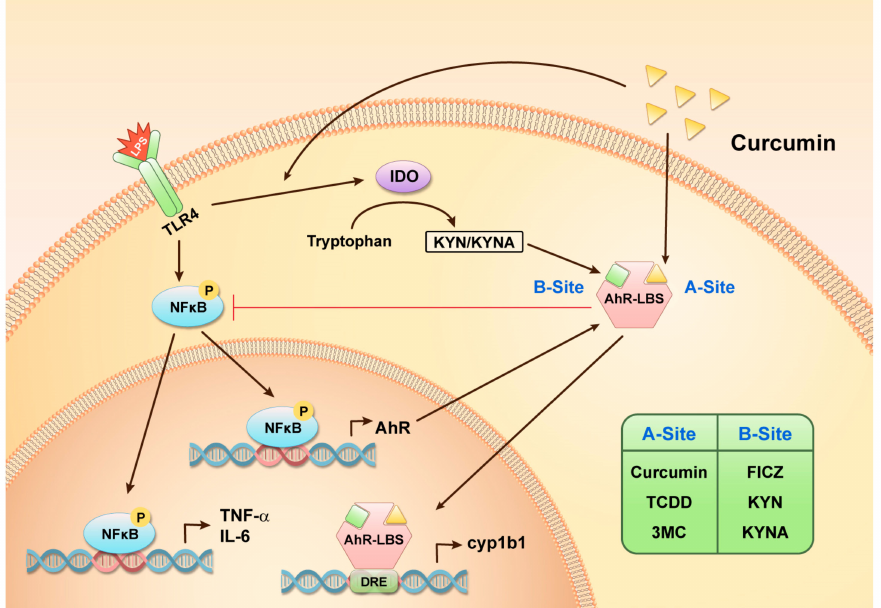
Figure 7. Mechanism of the anti-inflammatory effects of curcumin in the context of LPS-induced inflammation in astrocytes. The figure illustrates an overview of the curcumin-AhR pathway, which is involved in regulating LPS-induced proinflammatory cytokines. Our findings indicated that AhR may have two ligand-binding sites and these different ligands may synergistically modulate LPS-induced inflammation as shown in the figure. AhR-LBS, AhR ligand-binding